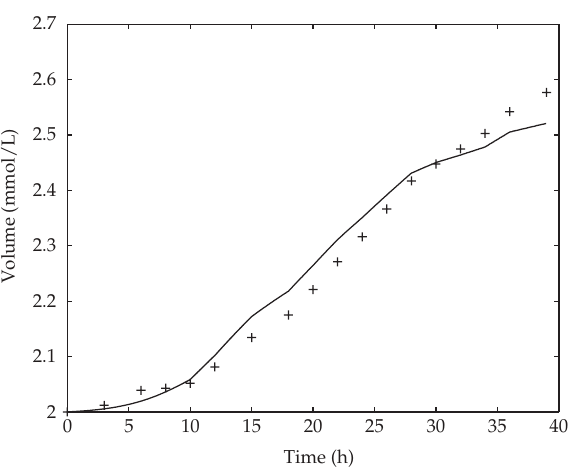
Figure 8: Comparison of the volume of solution between experimental data and computational results.